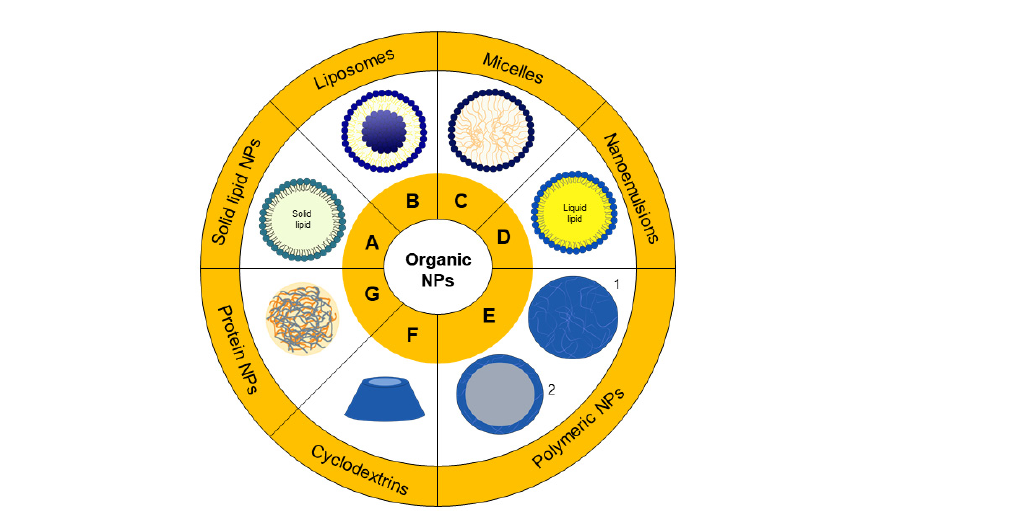
Figure 3. Different organic nanoparticles that can be used for photodynamic therapy: ( A ) solid lipid nanoparticles, ( B ) liposomes, ( C ) micelles, ( D ) nano-emulsions, ( E ) polymeric nanoparticles, ( F ) cyclodextrins and ( G ) protein nanoparticles.